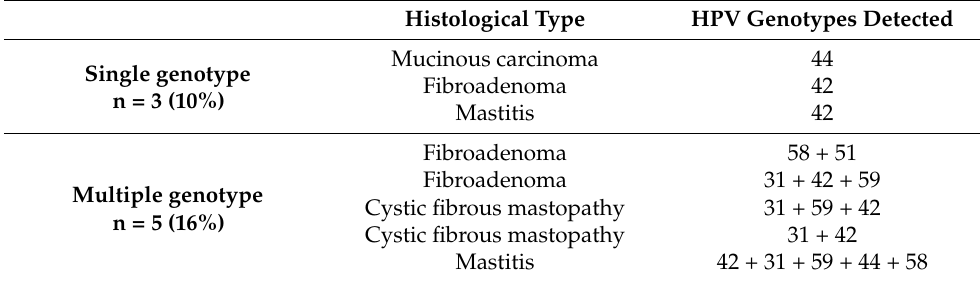
Table 5. Genotyping of VHP in FFPE breast